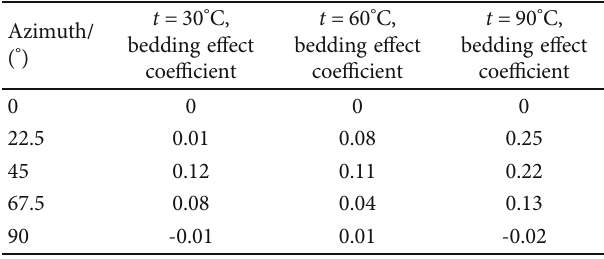
Table 2: Simulation results of shale compressive strength. Azimuth/